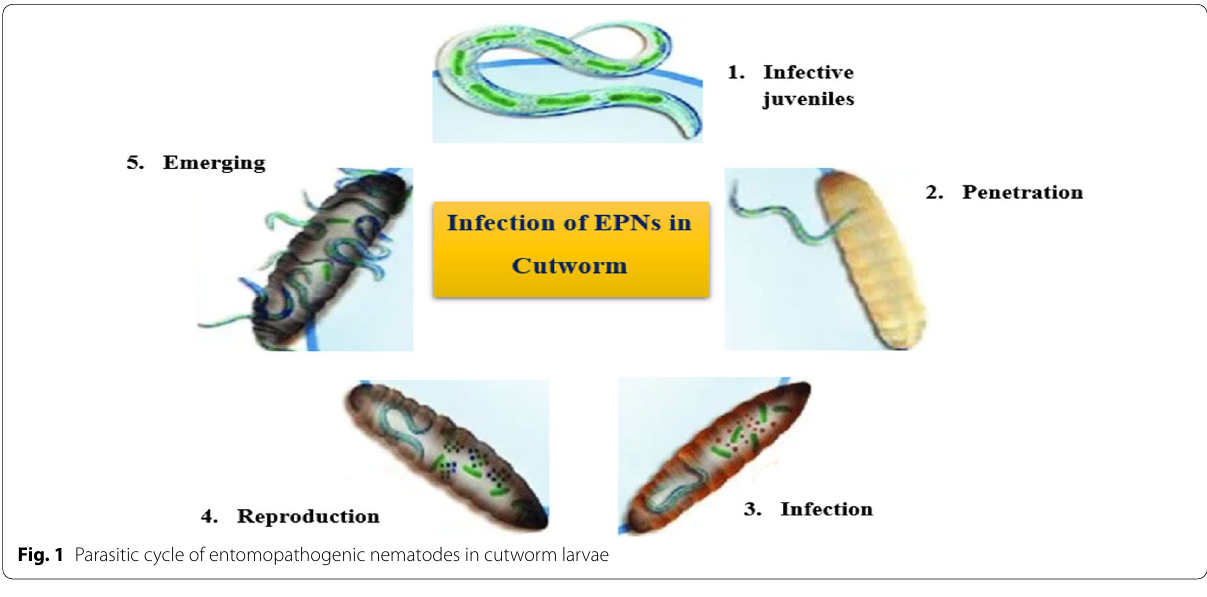
Fig. 1 Parasitic cycle of entomopathogenic nematodes in cutworm larvae